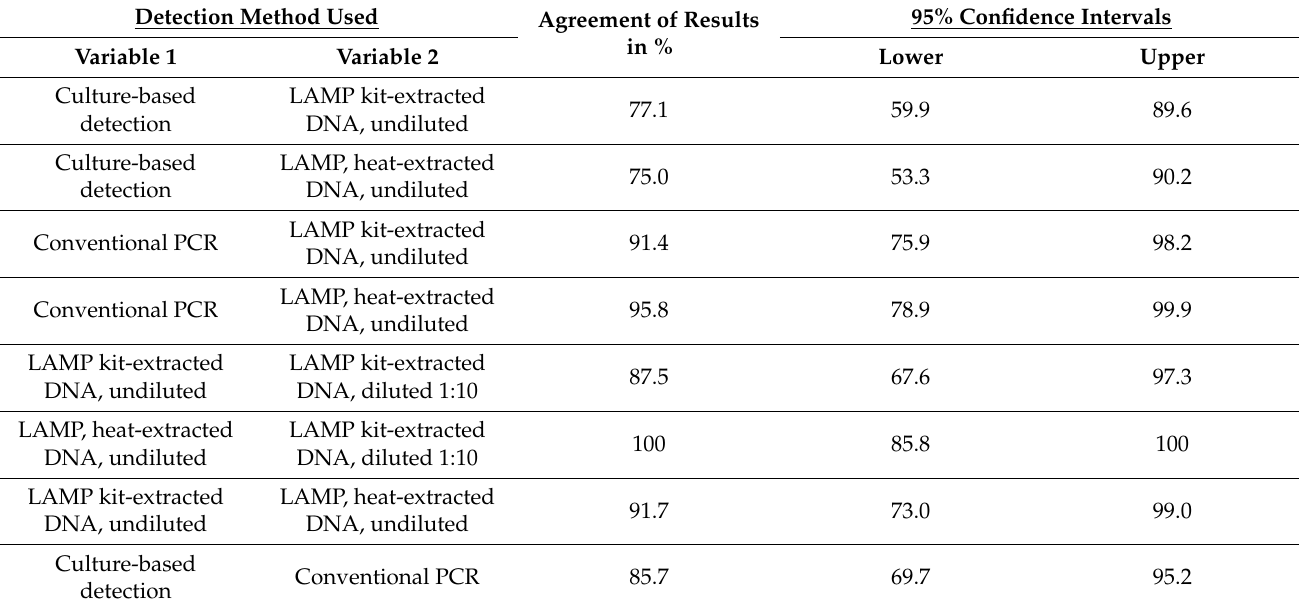
Table 6. Agreement of results between different methods for the detection of G. parasuis in clinical